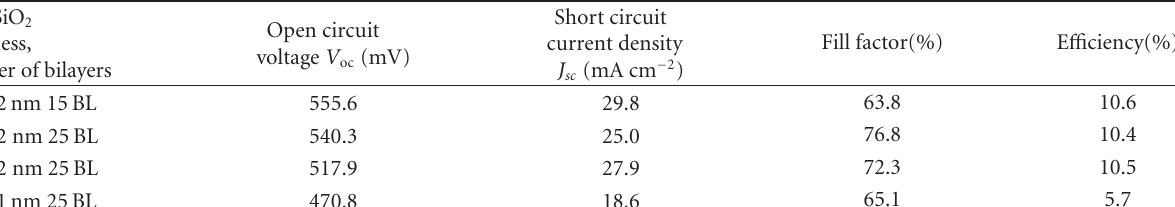
Table 2: Electrical measurements of solar cell with di ff erent size silicon nanocrystals embedded in layers of silicon rich oxide (SRO)/Silicon